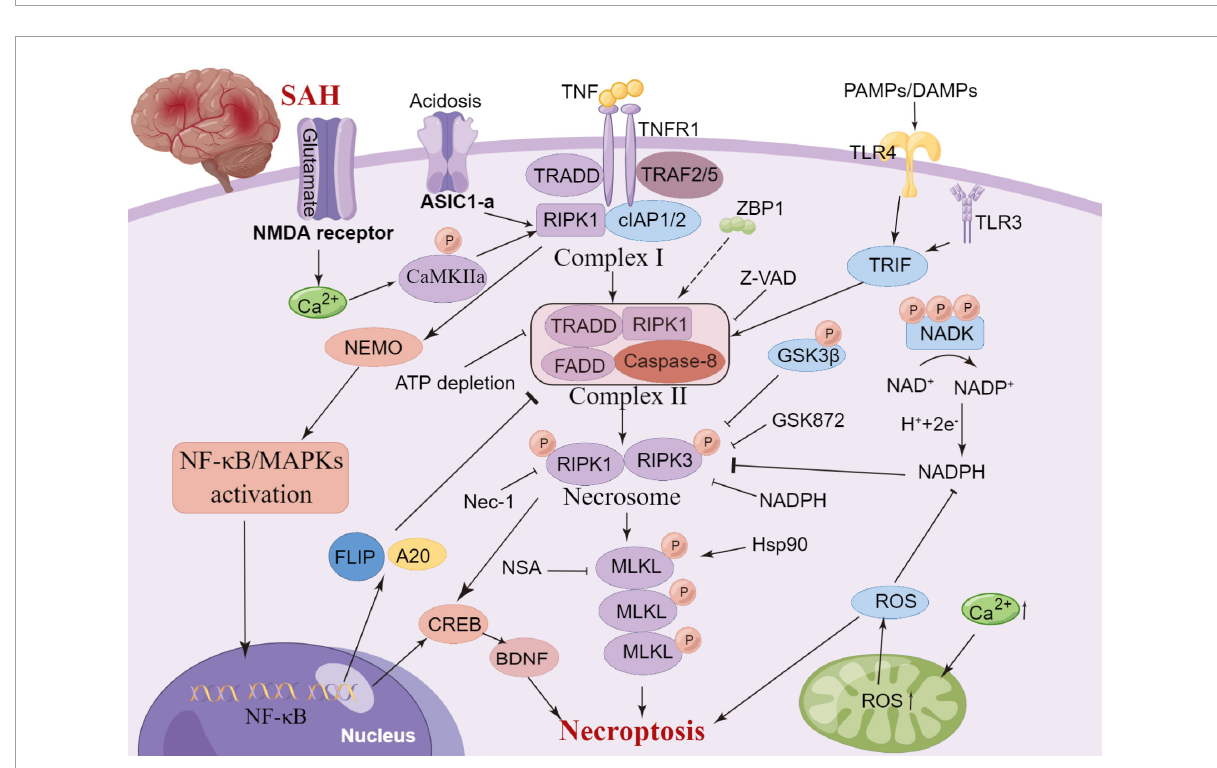
FIGURE5 Molecular mechanisms of necroptosis from subarachnoid hemorrhage to early brain injury (EBI).